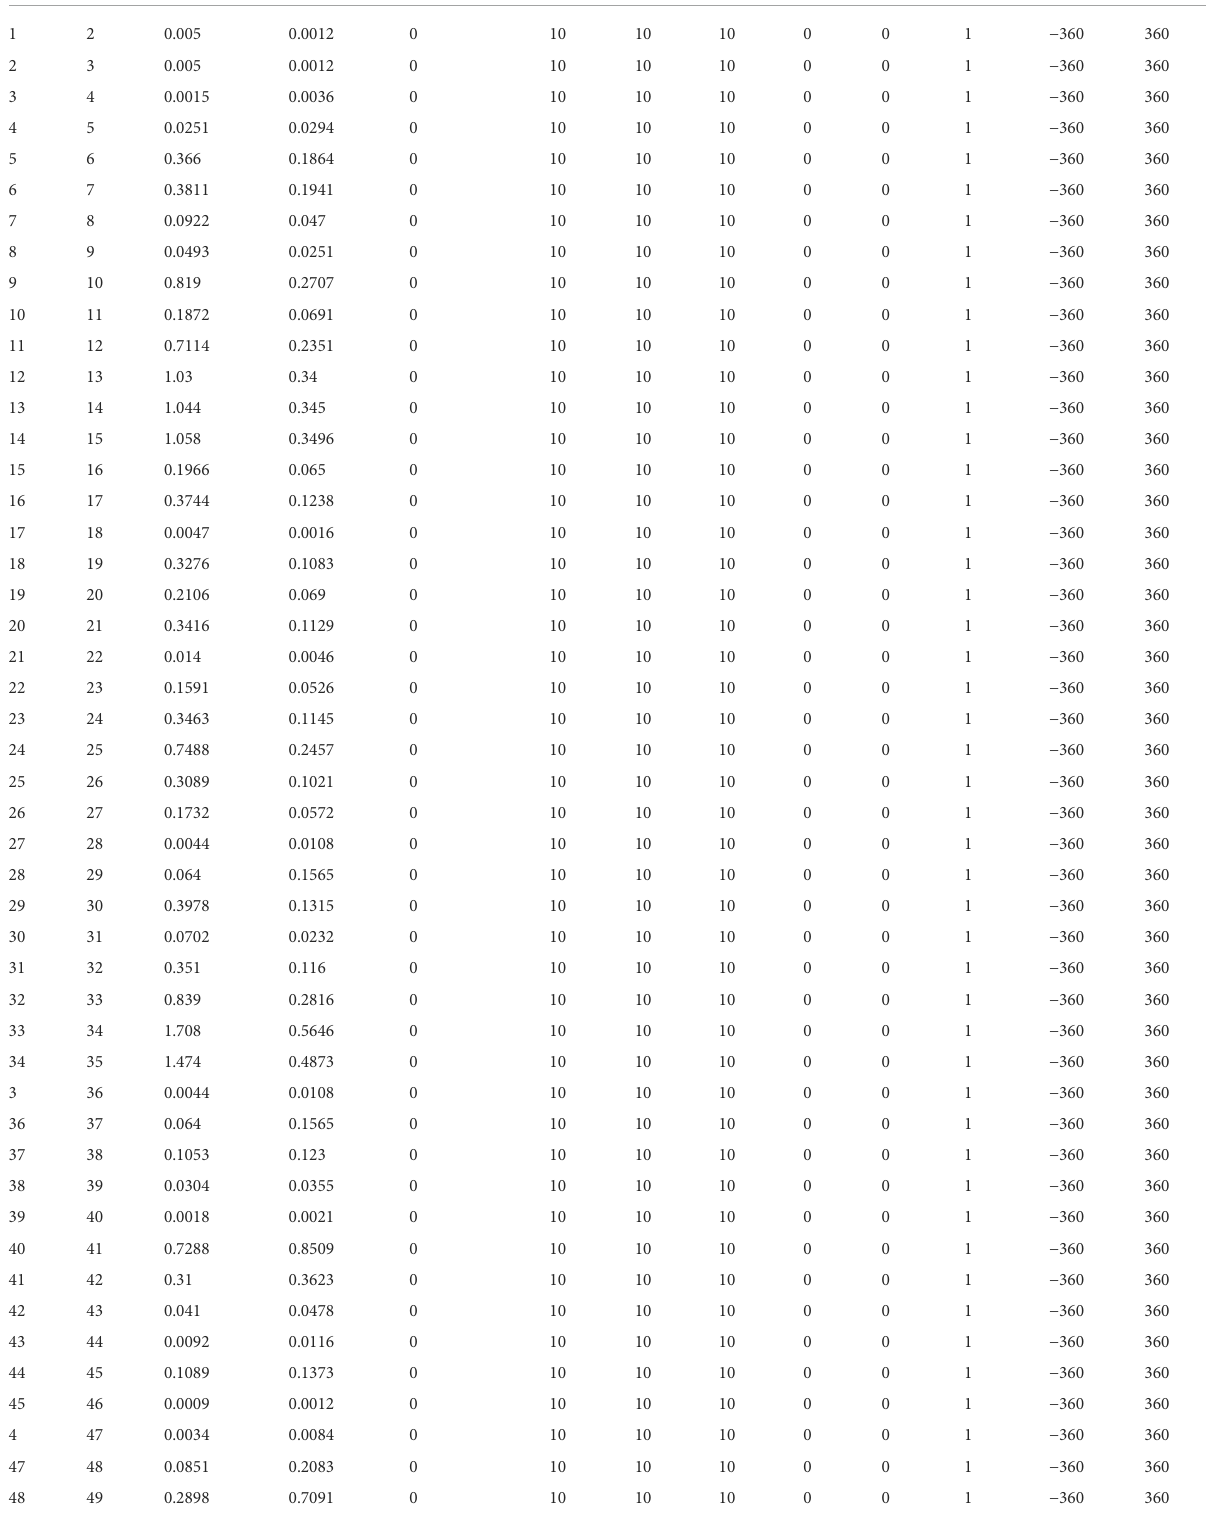
TABLE 4 Parameters of the IEEE-69 node